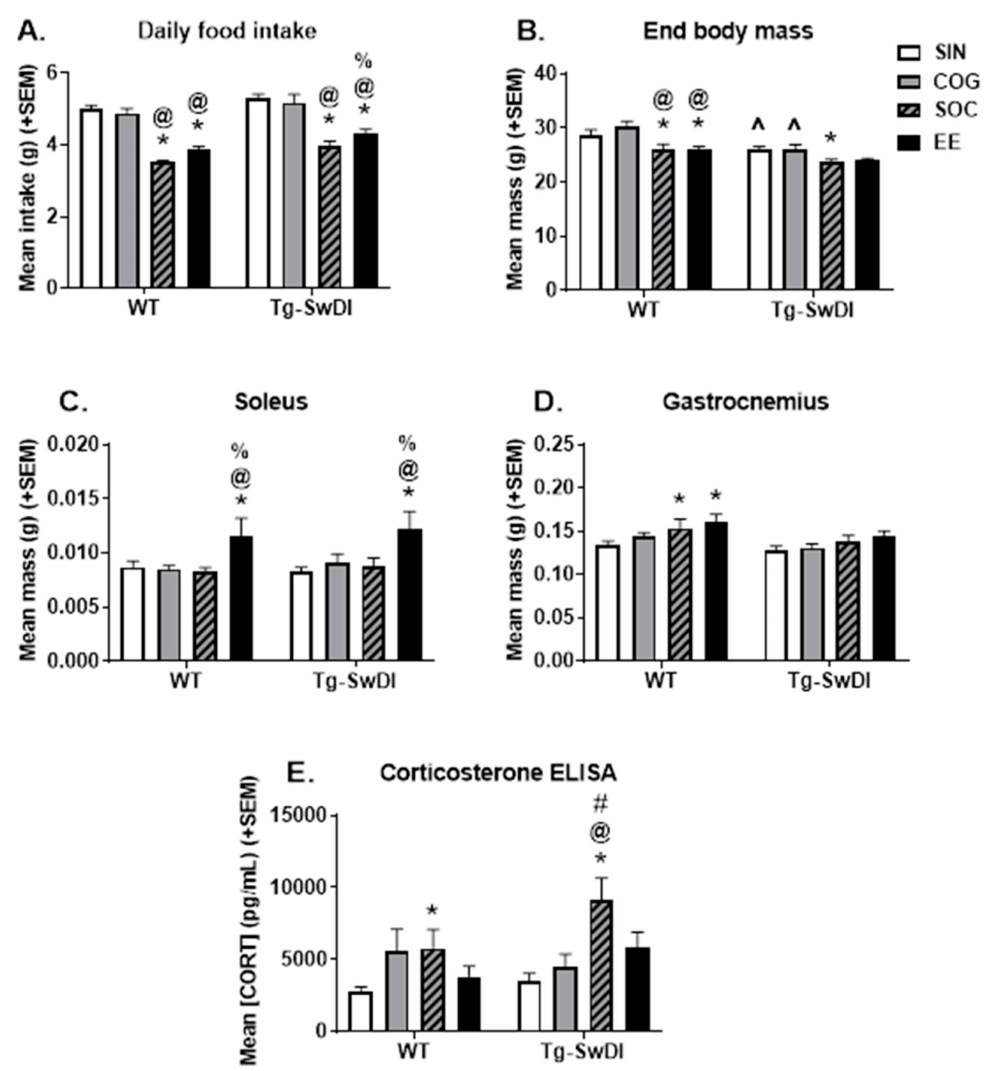
Figure 3. Physiological measures. ( A ) Mean daily food intake over the course of the 4-month intervention period. Generally, Tg-SwDI mice ate more than WT mice, while SOC and EE housing attenuated food intake in WT and Tg-SwDI mice. ( B ) Body weight at the end of the experiment. Generally, the Tg-SwDI mice weighed less than the WT mice. SOC (both WT and Tg-SwDI), and EE (WT only) reduced body weight. ( C ) Soleus mass was increased by EE housing in both WT and Tg-SwDI mice. ( D ) Overall, Tg-SwDI mice tended to have a smaller gastrocnemius. There were trends of SOC and EE mice of both genotypes having a larger gastrocnemius, but this was only significant in WT mice. ( E ) Corticosterone levels measured by ELISA. * p < 0.05 vs. SIN of the same genotype, @ p < 0.05 vs. COG of the same genotype, % p < 0.05 vs. SOC of the same genotype, # p < 0.05 vs. EE of the same genotype, ˆ p < 0.05 vs. WT in the same housing